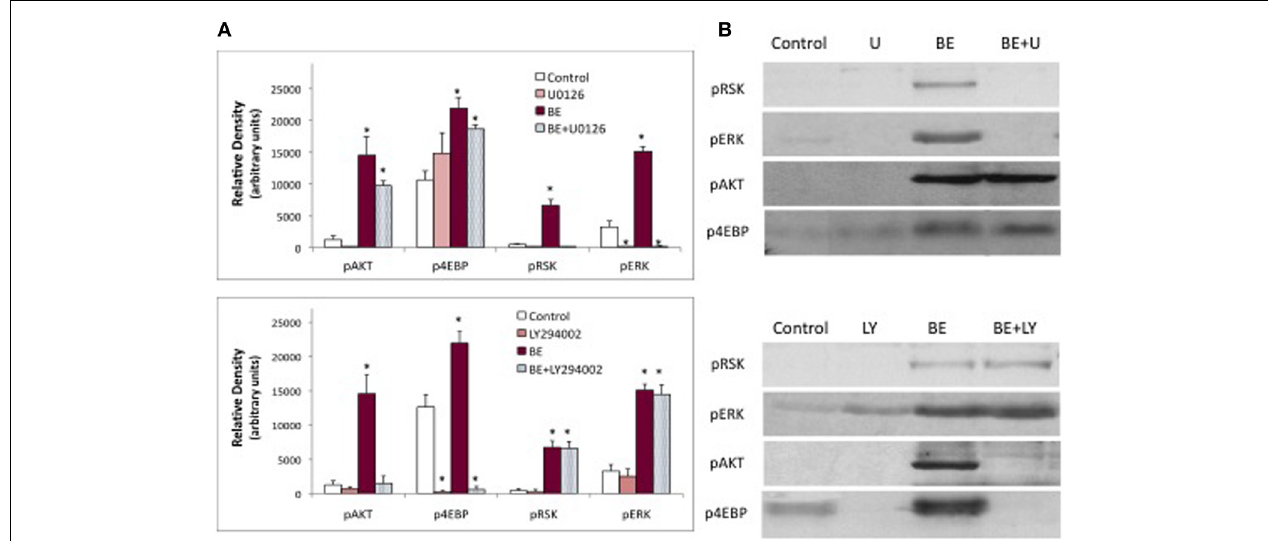
FIGURE 6 | Effects of PI3K inhibitor (LY294002) and MEK inhibitor (U0126) on protein phosphorylation. Western blots were prepared from prothoracic glands described in Figure 5 , and probed for phosphoproteins. Treatments were as follows: no hormone (Control), 10uM U0126 (U), 60uM LY294002 (LY), brain extract (BE, 0.5 brain